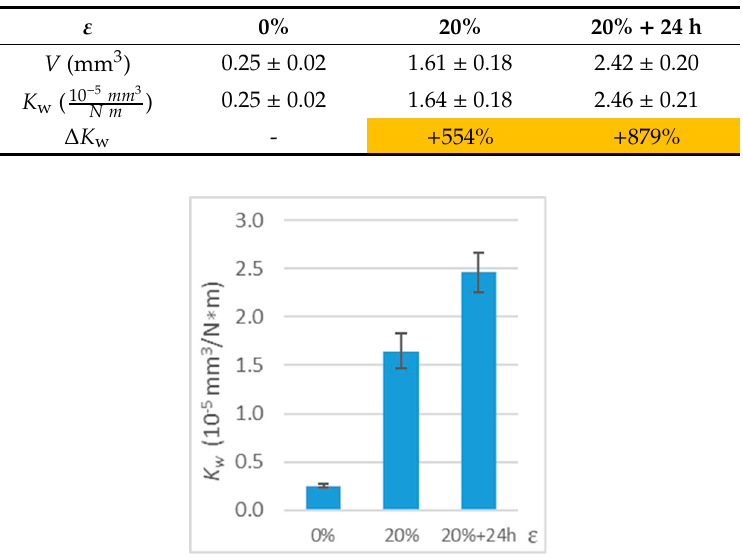
Figure 11. Wear coefficient ( K w ) for deformed polymer (working with steel, tension, parallel direction, 24h, v = 0.33 m/s, and T 0 = 23 °C).